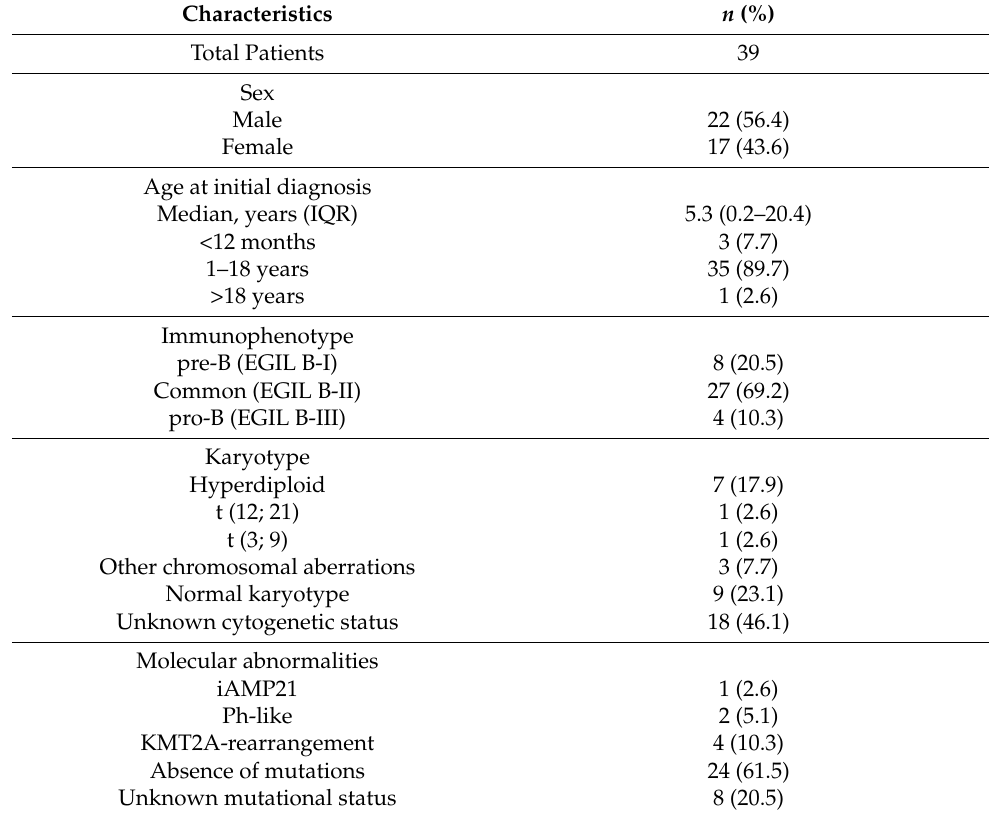
Table 1. Characteristics of the 39 patients enrolled in the observational